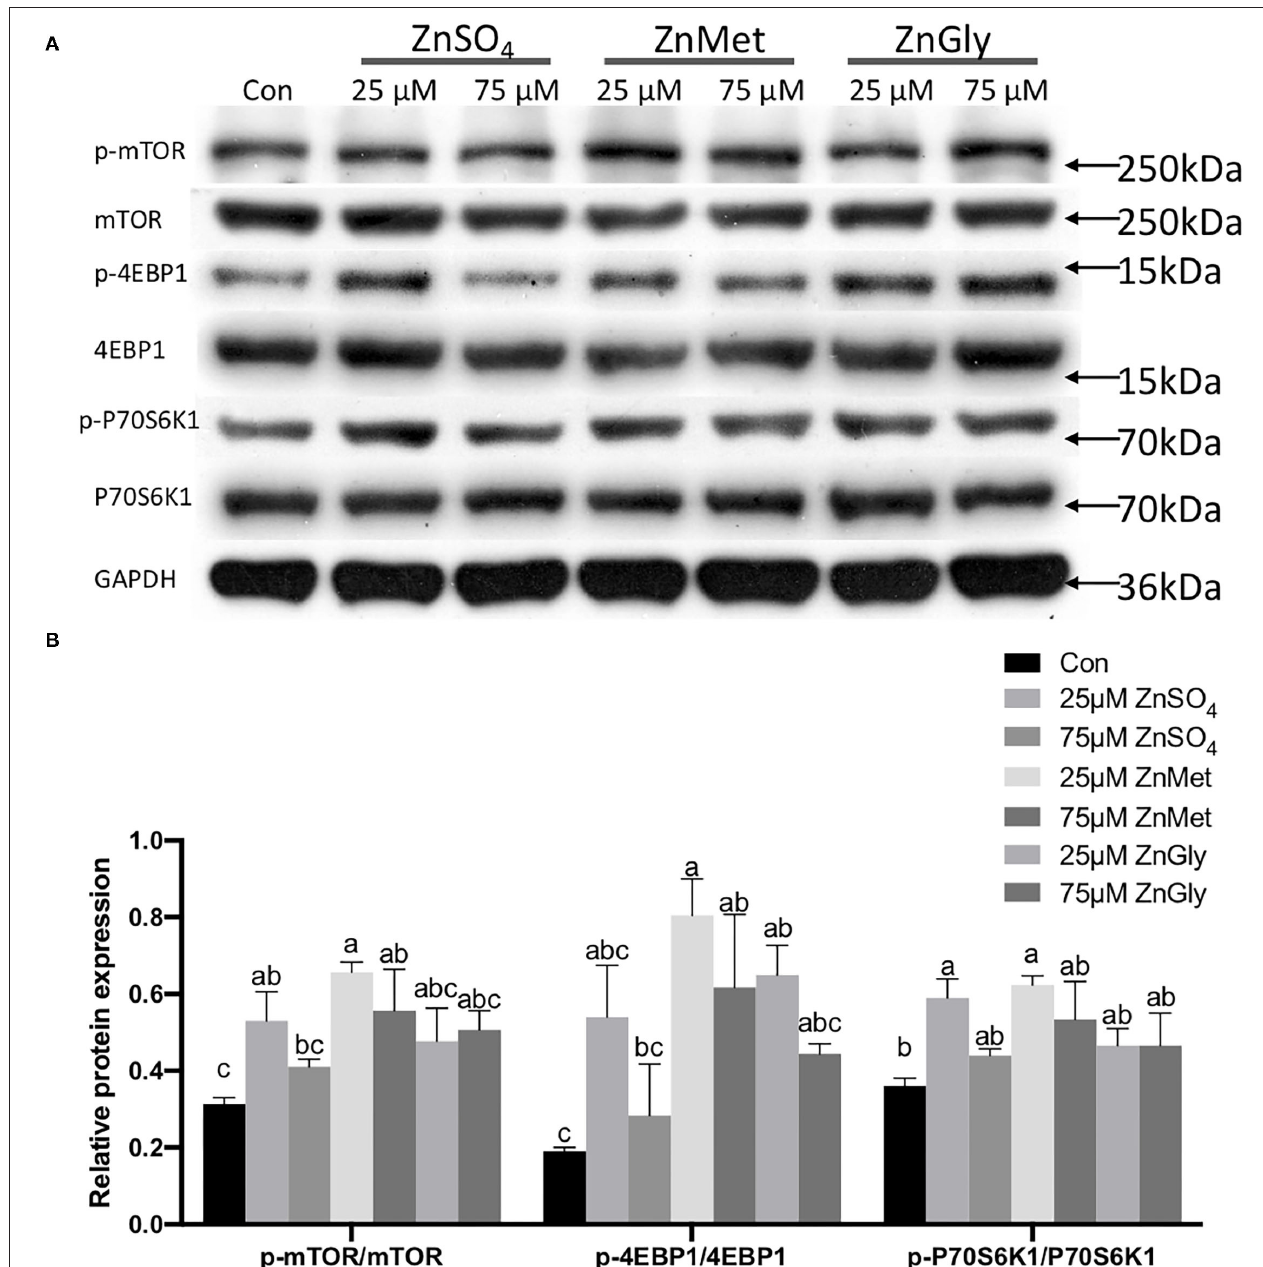
FIGURE 5 | Phosphorylated protein expression levels of mTOR signaling pathway (mTOR, 4EBP1, and P70S6K1) (A) and the ratios of p-mTOR to mTOR, p-4EBP1 to 4EBP1, and p-P70S6K1–P70S6K1 (B) are regulated by adding different zinc sources.